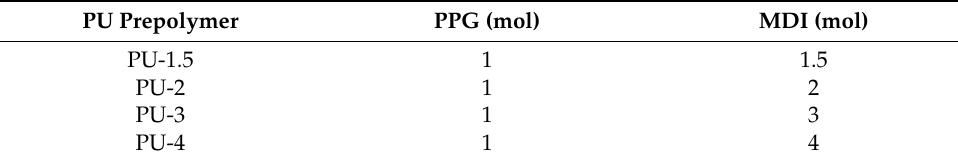
Table 1. Preparation of blocked isocyanate-terminated PU prepolymers.